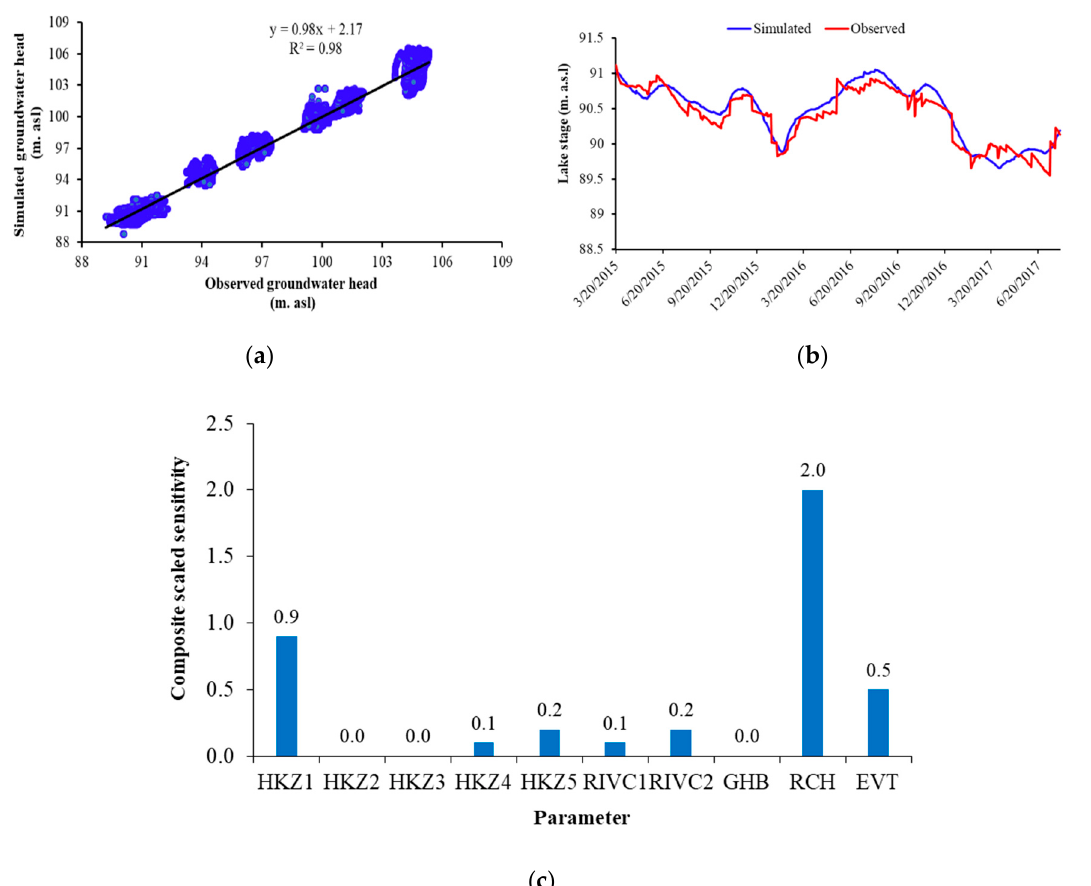
Figure 7. Model calibration. ( a ) Scatter plot for simulated versus observed groundwater piezometric heads; ( b ) simulated and observed daily variability of lake stages; ( c ) composite scaled sensitivities calculated with the parameter values.